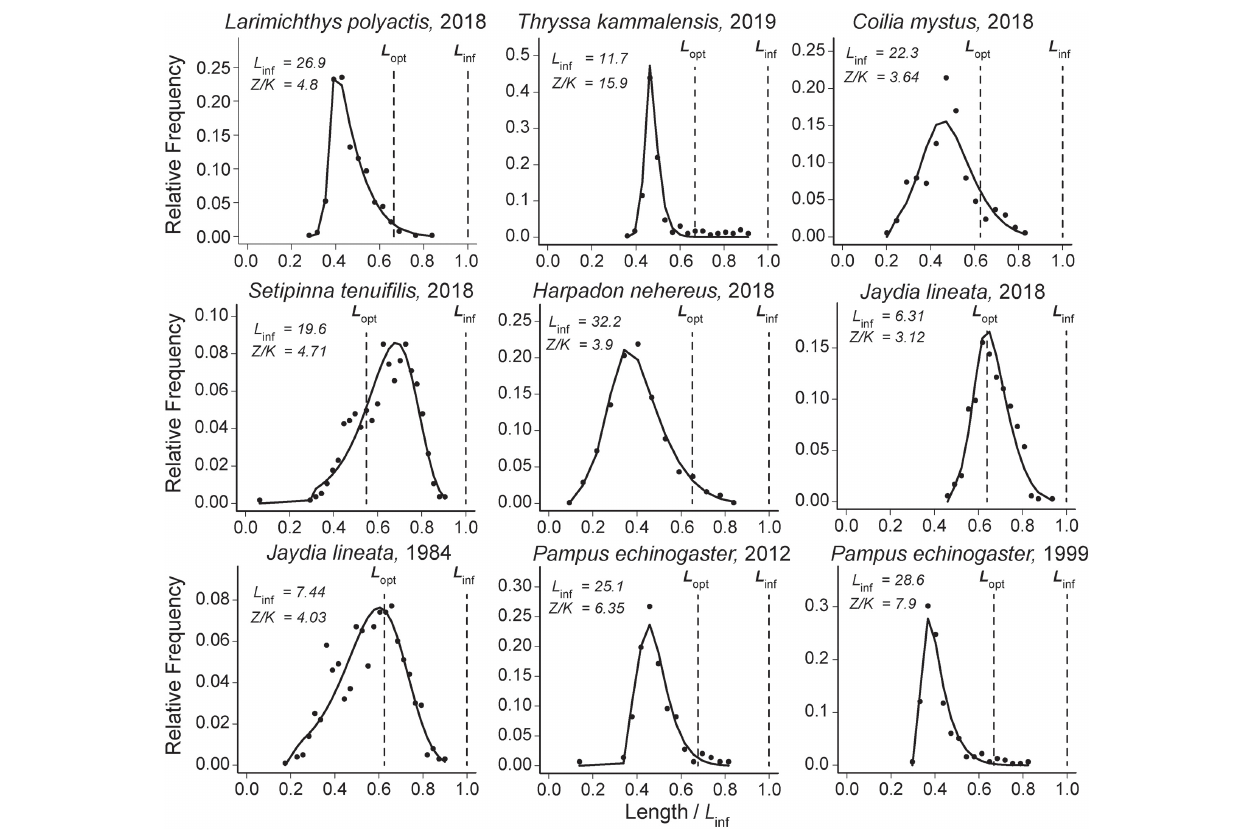
FIGURE 3 | Graphical outputs of LBB analyses, showing the fit of the main LBB equation. Black dots indicated the observed LF data. L opt and L inf were illustrated by two dash lines.